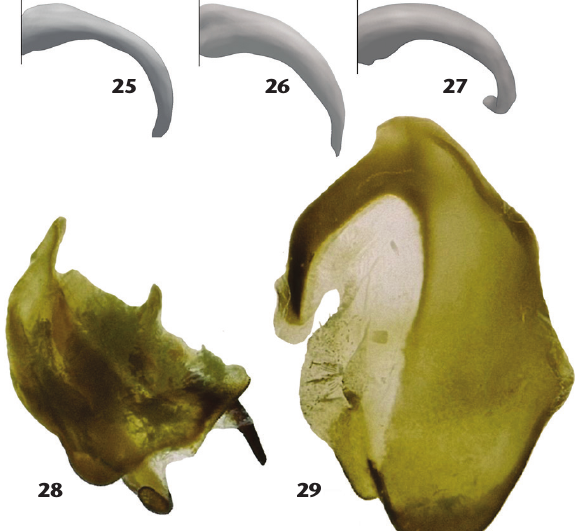
Figures 25-29. Variations in the genitalia of species of Paraphotina : (25-27) P. insolita , pseudophallus, (25) from Meta, Colombia, (26) from Amazonas, Brazil, (27) from Roraima, Brazil. (28-29) P. venezu elana , external genitalia of holotype male, (28) left epiphallus (dorsal view), (29) hypophallus (ventral view). Photos by courtesy of Kai Schütte